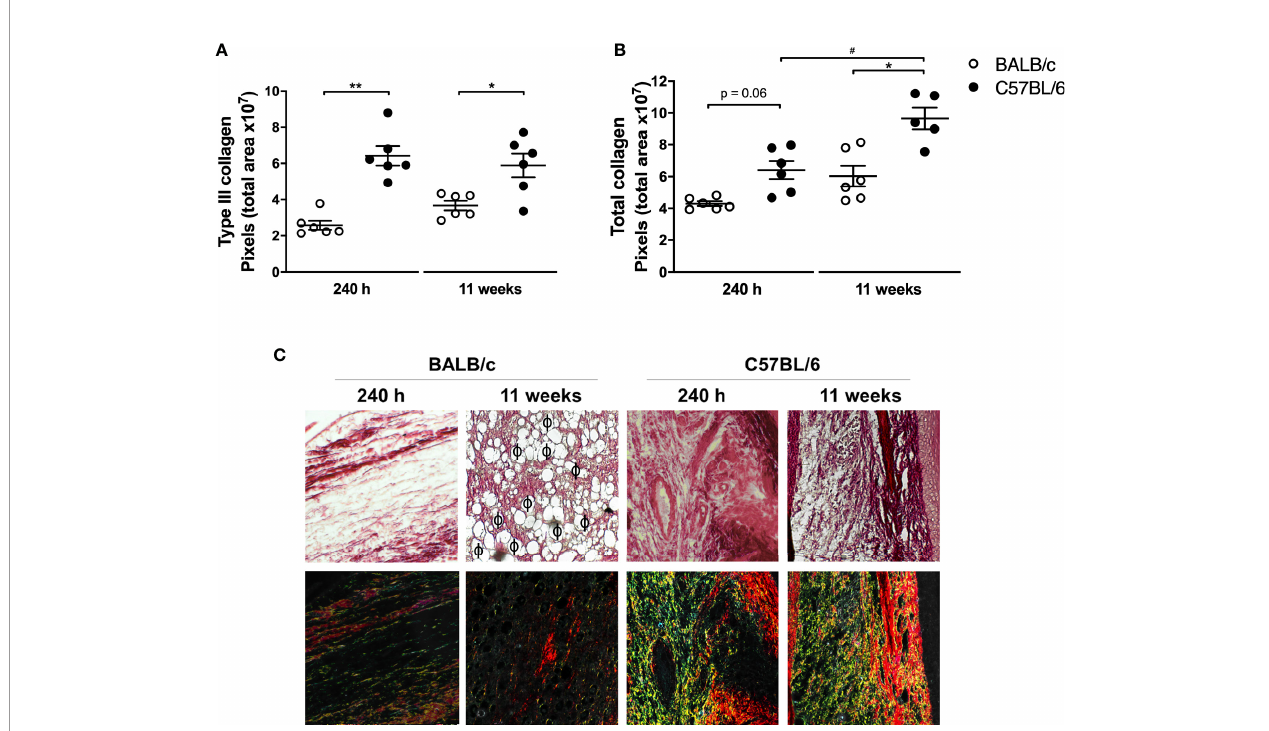
FIGURE 5 | Analysis of collagen in mice paws infected with L. amazonensis . Histological sections of the paws of L. amazonensis -infected BALB/c and C57BL/6 mice for 240 h or 11 weeks p.i. were stained with Sirius Red to measure (A) total collagen and (B) type III collagen using the Image-Pro Plus. * Signi fi cant difference between the mice strains infected by L. amazonensis , p ≤ 0.05; **p ≤ 0.01. # Signi fi cant difference of time points in C57BL/6 mice, p ≤ 0.05. (C) Representative fi gures of histological sections of the paws of BALB/c and C57BL/6 mice infected by L. amazonensis for 240 h and 11 weeks. f — Indication of some parasitophorous vacuoles. The fi bers stained in red correspond to type I collagen and those in yellow/green correspond to deposited type III collagen. Data from (A, B) represent the mean ± SEM (n ≥ 5).